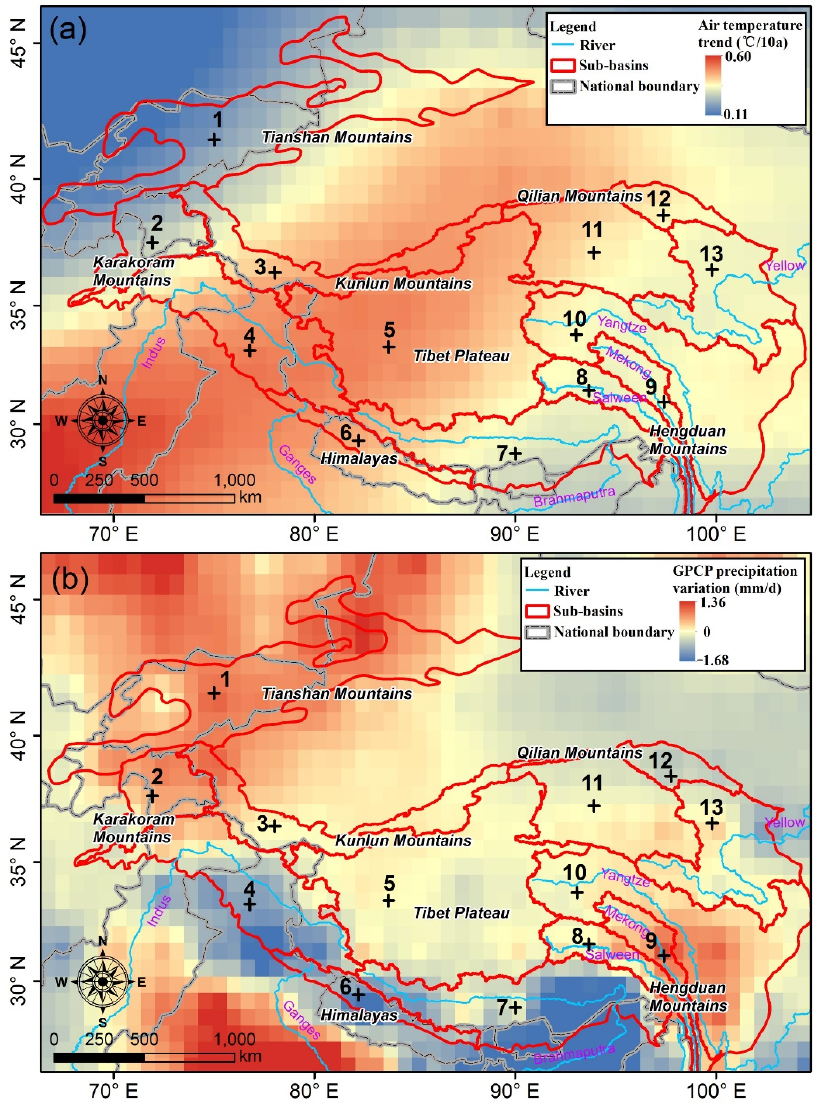
Figure 10. Spatial variation in ( a ) air temperature, as derived from NCEP Reanalysis data, and ( b ) precipitation, as derived from GPCP data, from 1979 to 2016 in the HMA region. Plus symbols indicate the different sub-basins listed in Table 2.